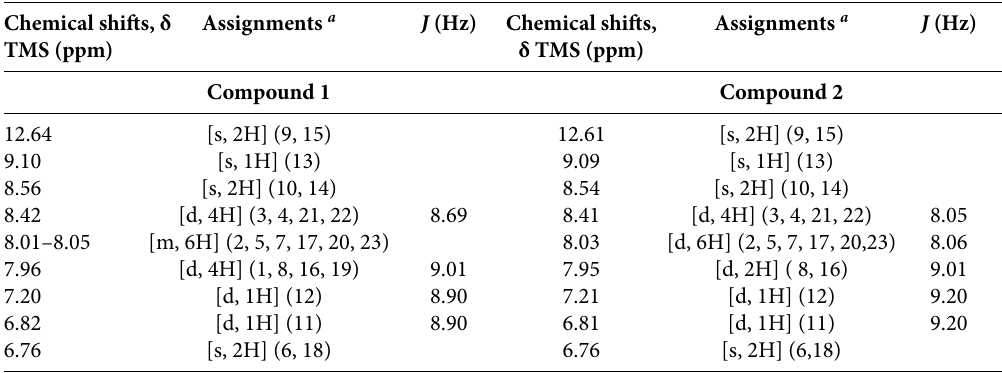
Table 1: 1 HNMR chemical shifts of ligands 1 and 2 Chemical shifts,